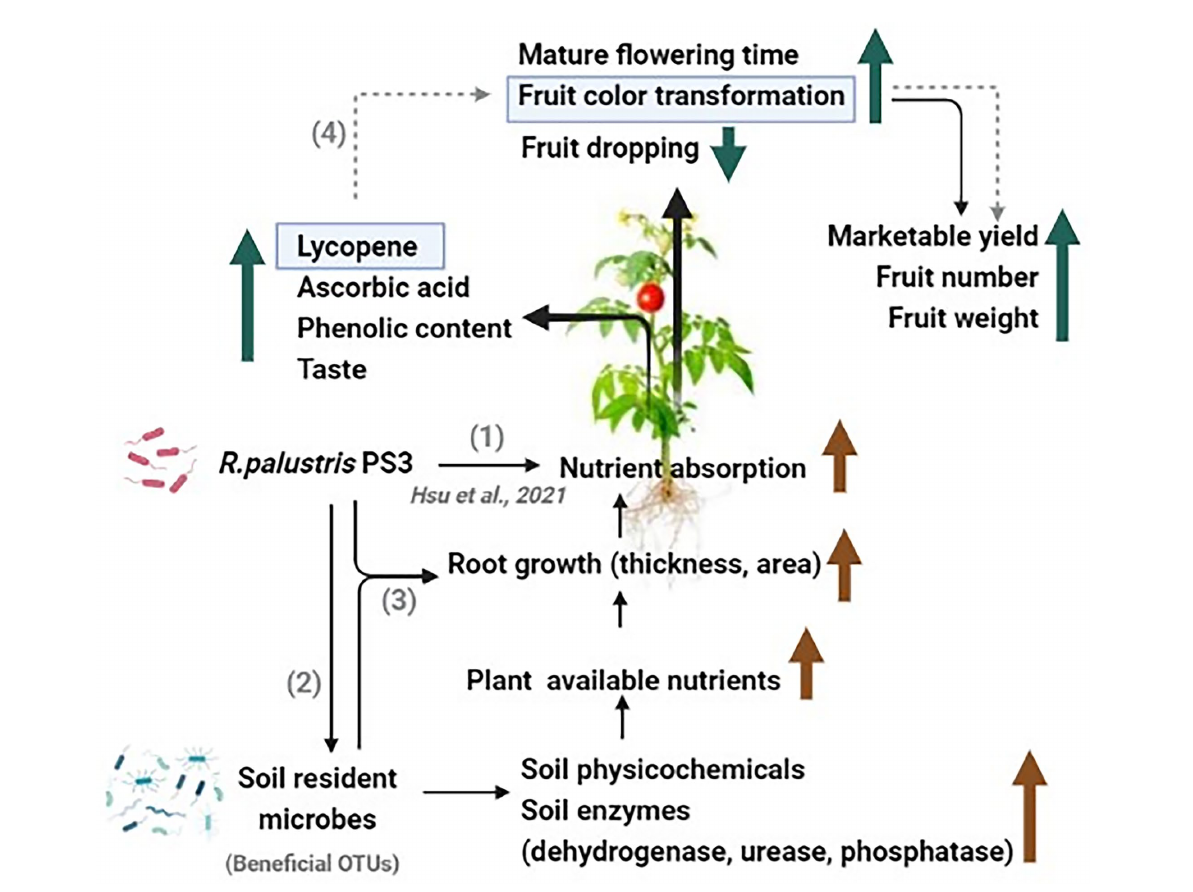
FIGURE 9 A schematic diagram proposed to explain the potential mechanism by which Rhodopseudomonas palustris PS3 could affect tomato development and quality under organic farming systems. (1) Rhodopseudomonas palustris PS3 improves the nutrient uptake of plants (Hsu et al., 2021). (2) Rhodopseudomonas palustris PS3 promotes fruit growth and quality by altering the soil microbiome, and enhancing soil health and soil enzyme activities. (3) Rhodopseudomonas palustris PS3 was applied alone or in combination with other beneficial microbes to enhance root growth and nutrient cycling. (4) Rhodopseudomonas palustris PS3 improves fruit color transformation by increasing the lycopene content, thereby enhancing the marketable yield (in